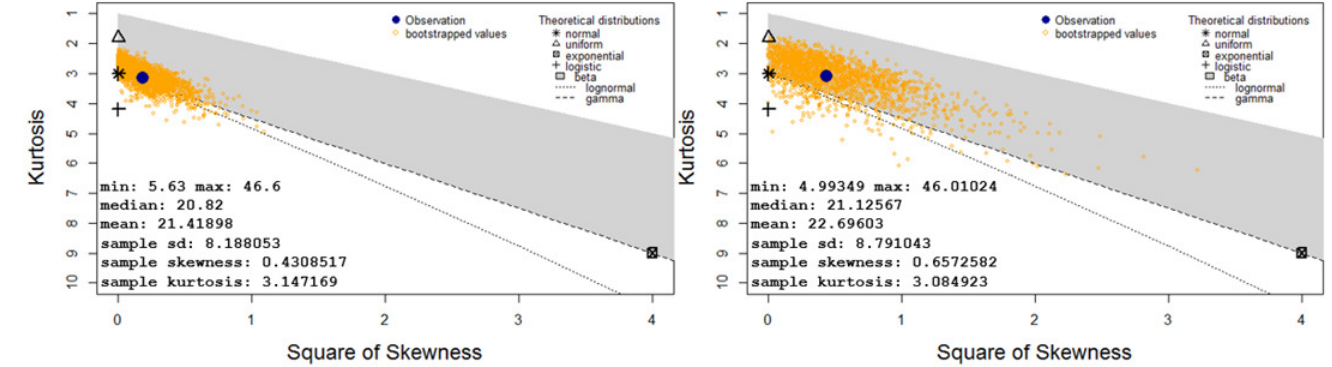
Figure 10. Comparison of Cullen and Frey graphs [87] with a 2000-sample bootstrap for the Pearson distributions of the Davis et al. [53] sample ( left ) and faint galaxies sample ( right ). Despite the Pearson distribution for the faint sample not fitting well to its data (i.e., not enough skewness or kurtosis), it is centered farther from the normal distribution on the Cullen and Frey graphs, illustrating this difference between the two samples. These plots were generated using the R package FITDISTRPLUS